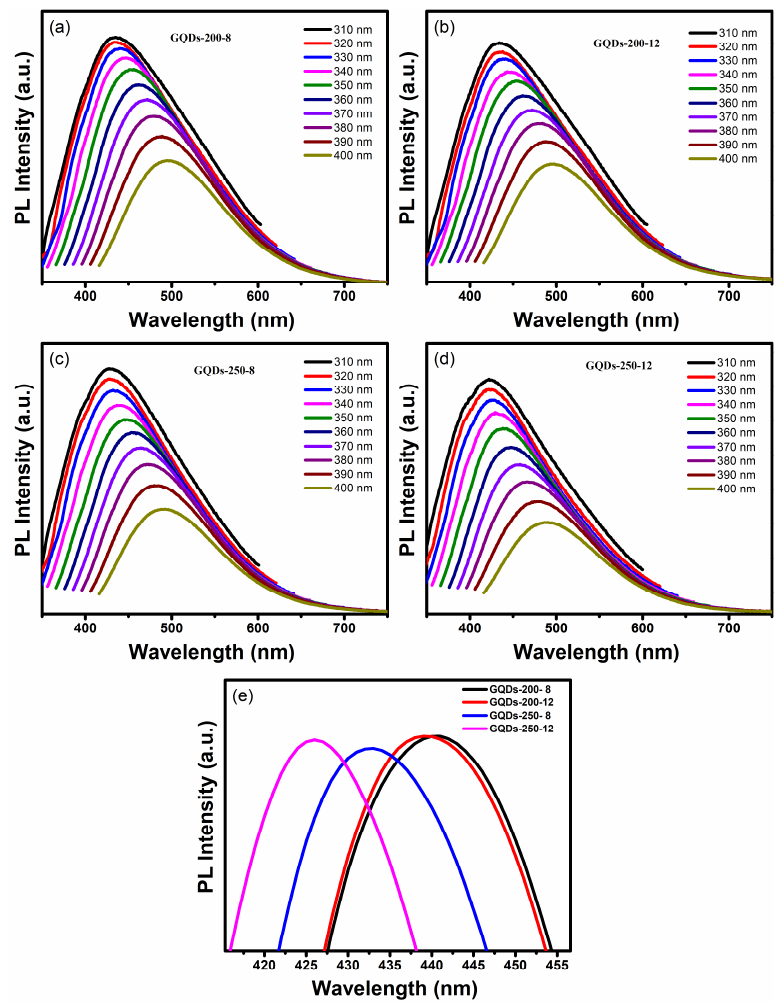
Figure 3. Photoluminescence emission spectra at a range of excitations from 310–400 nm for ( a ) GQDs-200-8, ( b ) GQDs-200-12, ( c ) GQDs-250-8 and ( d ) GQDs-250-12. ( e ) The comparison of emission peak position for various GQDs at same excitation of 330 nm.